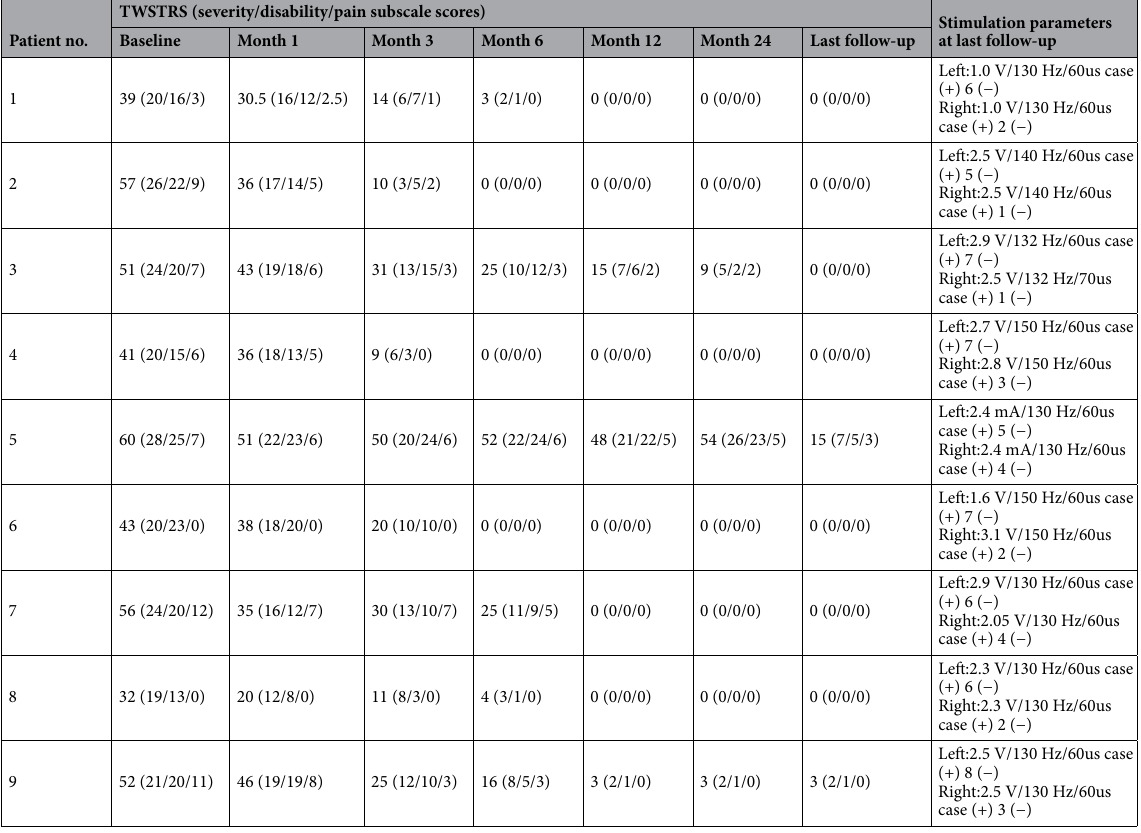
Table 3. The outcomes for TWSTRS and improvement from baseline. TWSTRS Toronto Western Spasmodic Torticollis Rating Scale. Mean values are expressed ± SD. *p values for improvement comparisons between baseline and follow-up time points after operation, as assessed using two tailed paired-sample t tests or Wilcoxon matched-pairs signed-rank